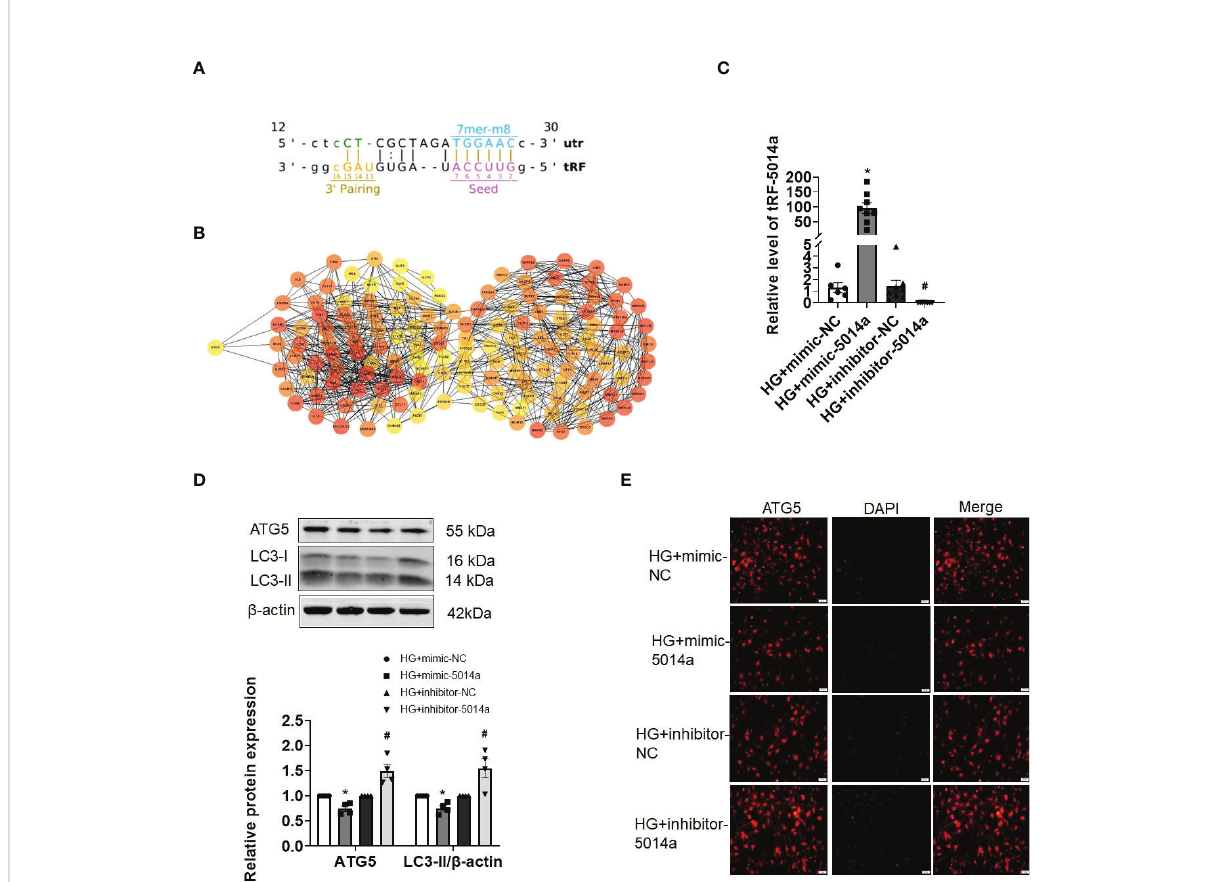
FIGURE 5 tRF-5014a regulated autophagy by targeting ATG5 in HG-treated primary cardiomyocytes. (A) Complementary binding site between tRF-5014a and the 3 ’ UTR of the ATG5 gene was found based on the miRanda and TargetScan algorithms. (B) PPI network analysis was carried out using the STRING database on the target genes of tRF-5014a. (C) The tRF-5014a levels in each group were detected by real-time PCR assay after the cells were transfected with tRF-5014a mimic or inhibitor. n = 6-8 in each group. * P < 0.05 versus HG + mimic-NC, # p < 0.05 versus HG + inhibitor-NC. (D) The levels of the autophagy-related proteins LC3-II and ATG5 were detected by western blot assay. n = 4 in each group. * P < 0.05 versus HG + mimic-NC, # p < 0.05 versus HG + inhibitor-NC. (E) Immuno fl uorescence analysis of ATG5 (red) in each group in primary cardiomyocytes was conducted. DAPI (blue) was used to stain the nucleus. HG, high glucose; mimic-5014a, tRF-5014a mimic; inhibitor-5014a, tRF-5014a inhibitor; mimic-NC, tRF-5014a mimic negative control; inhibitor-NC, tRF-5014a inhibitor negative